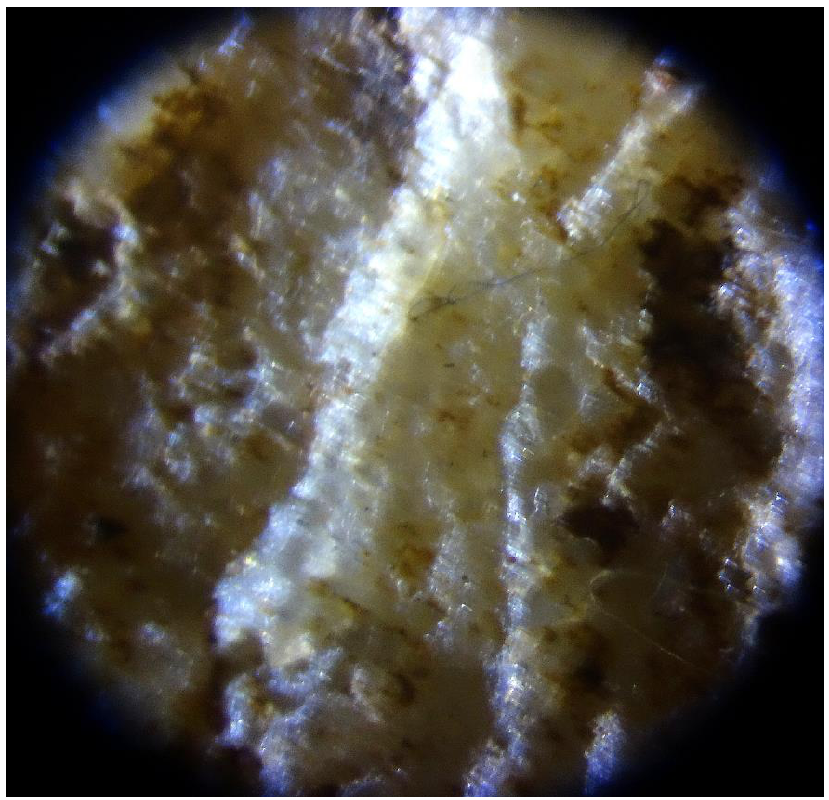
Figure 6. Field microscopic image of the left margin of cupule 14A, north wall of Daraki-Chattan Cave, showing stage 2 alteration of the quartzite